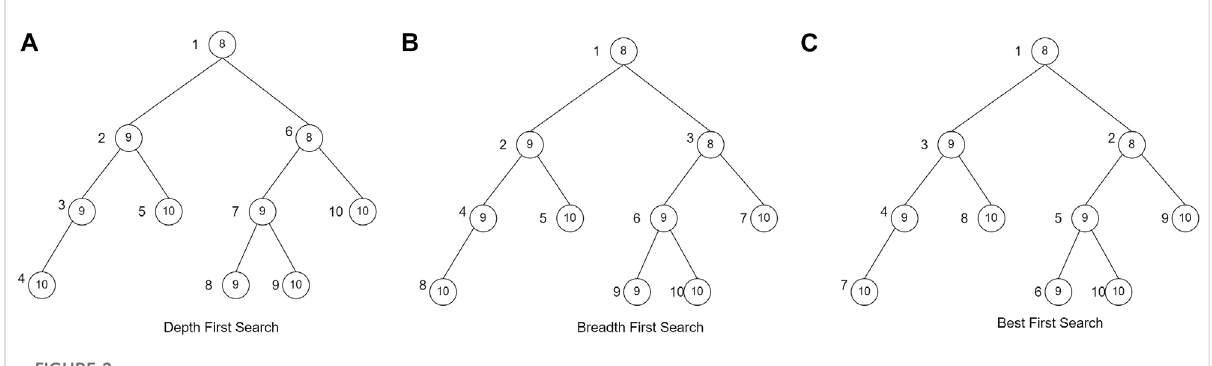
FIGURE 2 Searching strategy (Morrison et al., 2016)